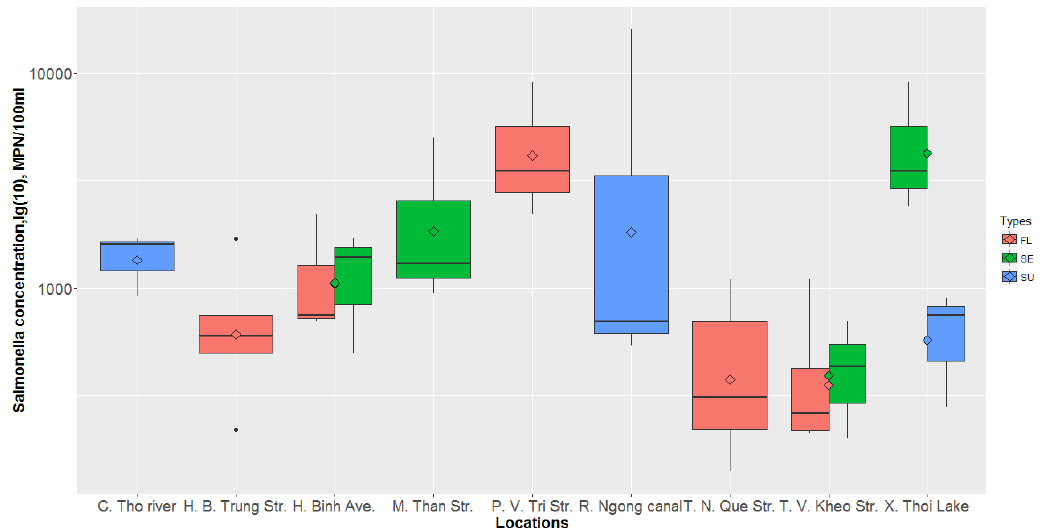
Figure 1. Salmonella concentration in flood water (FL), sewage (SE) and surface water (SU) bodies in Can Tho observed during October 2013 flood event [26].